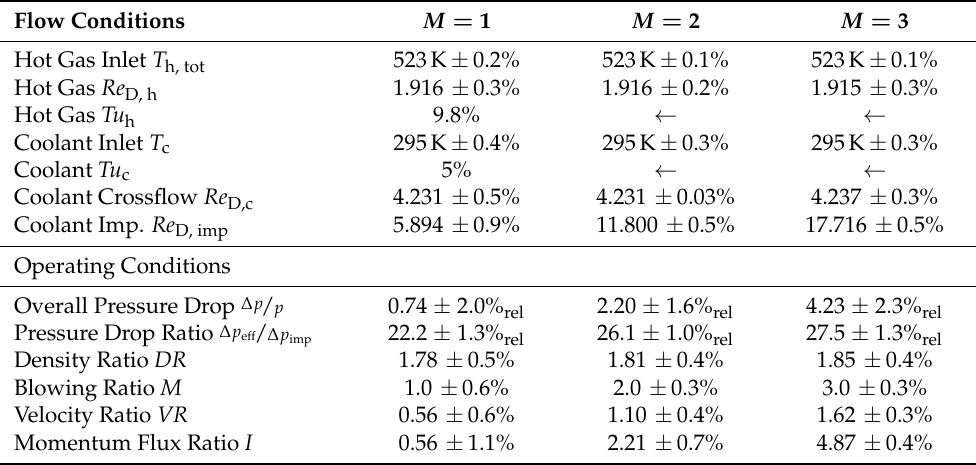
Table 2. Overview of flow conditions and operating conditions. Data are shown at three major blow- ing ratios, six analyzed in total. Deviation of values over all six different geometric test arrangements given for each blowing